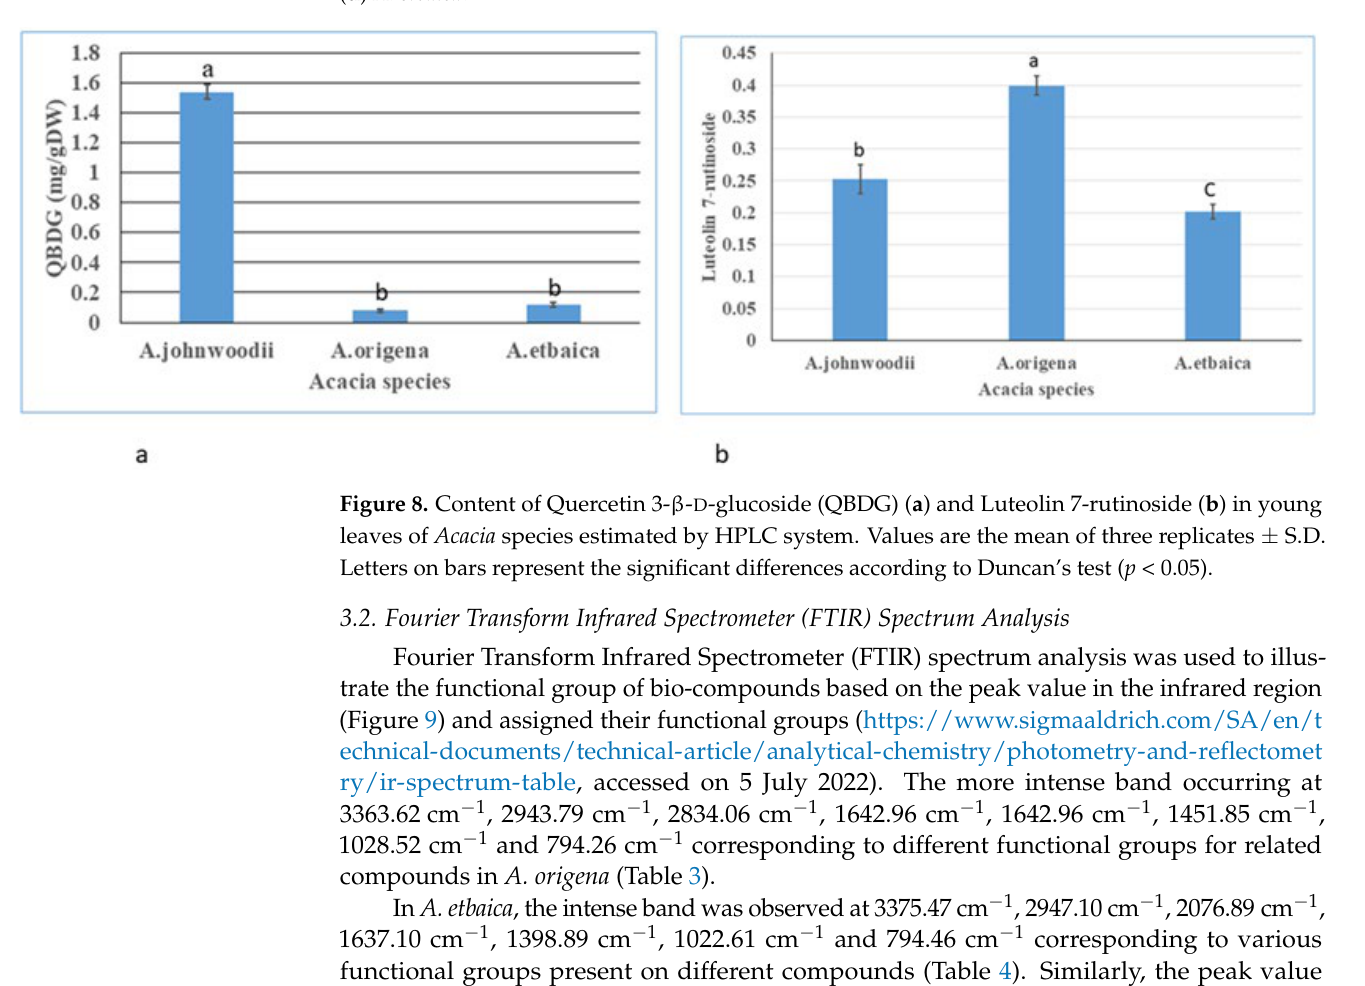
Figure 7. HPLC chromatogram of bioactive compound (Luteolin 7-rutinoside) extracted from young leaves of Acacia species; ( a ) Standard compound, Luteolin 7-rutinoside; ( b ) A. johnwoodii ; ( c ) A. origena ; ( d ) A. etbaica .